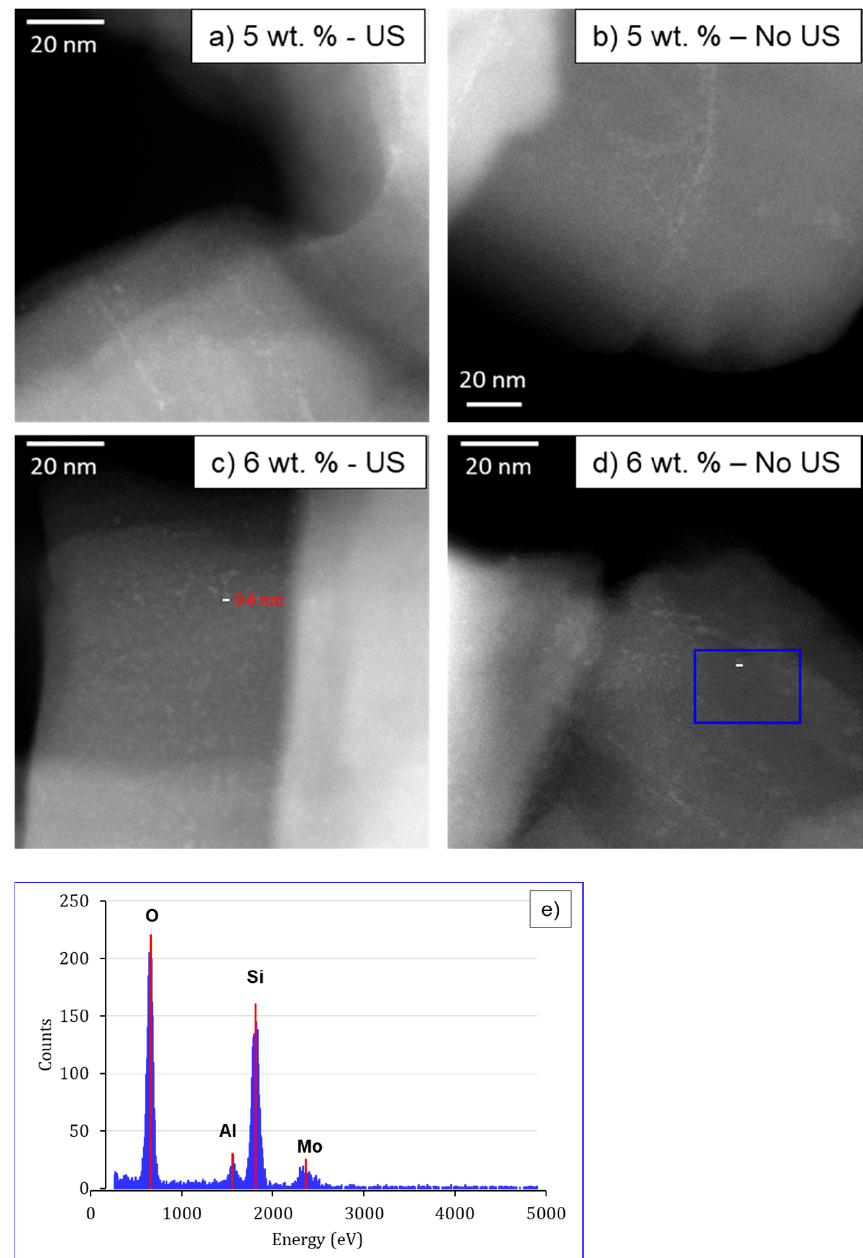
Figure 6. STEM micrographs of Mo/ZSM-5 catalyst prepared by ion-exchange ( a,c ) with ultrasound (US) and ( b,d ) without ultrasound (No-US). ( e ) EDX analysis of Mo/ZSM-5 catalyst 6 wt. % prepared with ultrasound. Table 2. SEM-EDX and XPS characterization of the atomic composition and metal loading for fresh catalysts.